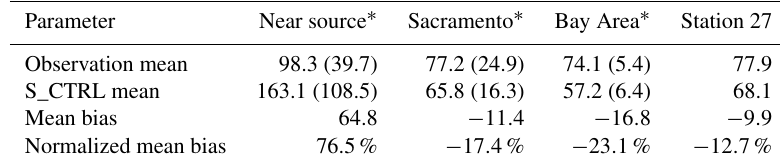
Table 3. Summary of model performance metrics for surface PM 2 . 5 (µgm − 3 ) for the simulation duration.